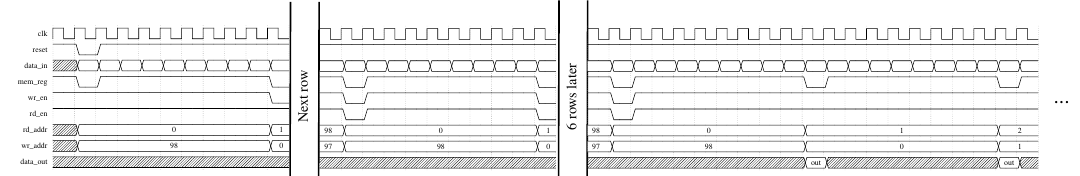
Figure 7. Simplified time diagram for using basic component with serial